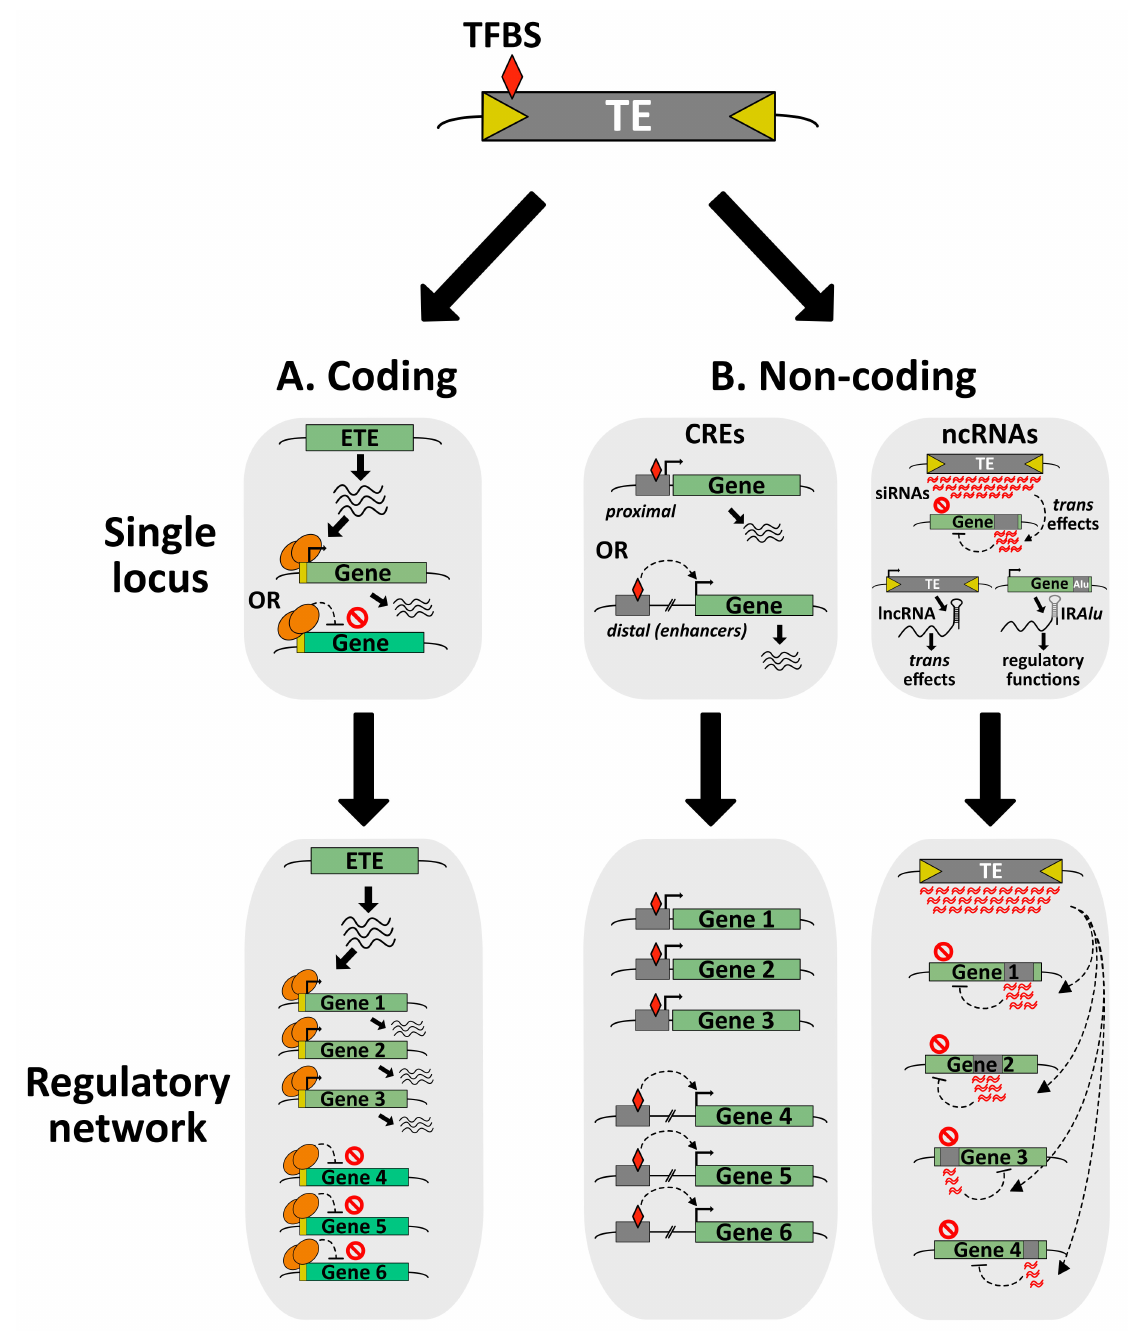
Figure 3. From single locus positive selection of TE-derived sequences to the elaboration of complex regulatory networks. ( A ) Co-option of a TE gene can positively impact the host through the regulation of specific gene with the ETE proteins acting as transcriptional activators or repressors, most likely by recruiting other chromatin factors (not represented here). At the genomic scale, ETE proteins can participate in large regulatory networks ensuring the fine tuning of gene expression. ( B ) Co-option of non-coding TE sequences acting as CREs can regulate the expression of single locus through proximal or distal interactions with the transcriptional machinery. Genome-wide, these TE-derived CREs can be part of interconnected gene regulatory networks. TFBS: transcription factor (TF)-binding sites. Co-option of non-coding TE sequences acting as ncRNAs can either target a discrete host gene as siRNAs or produce lncRNAs with trans regulatory functions. In the case of SINE Alu elements located in the 3 (cid:48) UTR of host genes, they can form IR Alu secondary structure of mRNAs involved in splicing, mRNA subcellular localization and other processes. In a hypothetical model, TE-derived siRNAs can engage in complex regulatory networks repressing several host